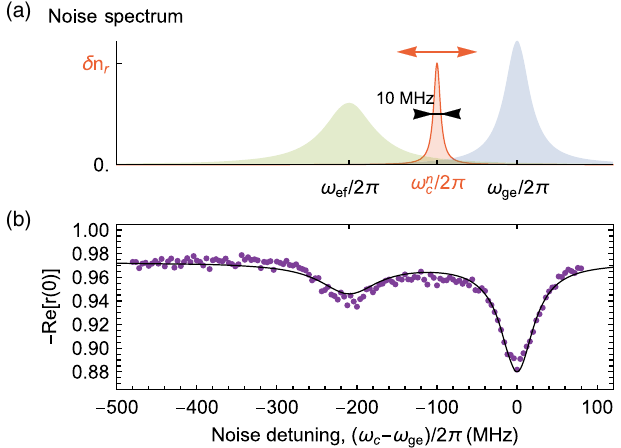
FIG. 8. Noise spectroscopy with Lorentzian noise. (a) Power spectral density of the applied noise, a 10-MHz Lorentzian with fixed amplitude, and varying center frequency ω part of the reflection coefficient at resonance, − Re ½ r ð 0 Þ(cid:3) , versus noise detuning from the fundamental transition (dots), and corresponding theory prediction (solid line) based on the same parameters as in Fig. 3.